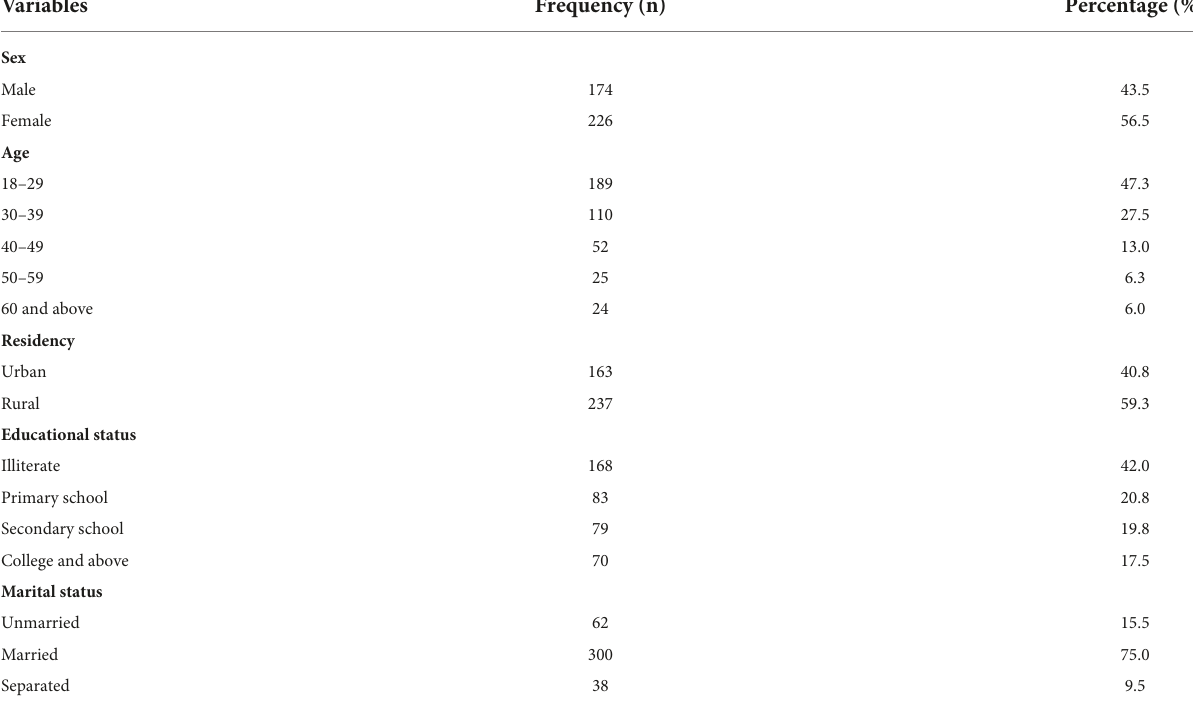
TABLE 1 Socio-demographic characteristics of surgical patients, N =